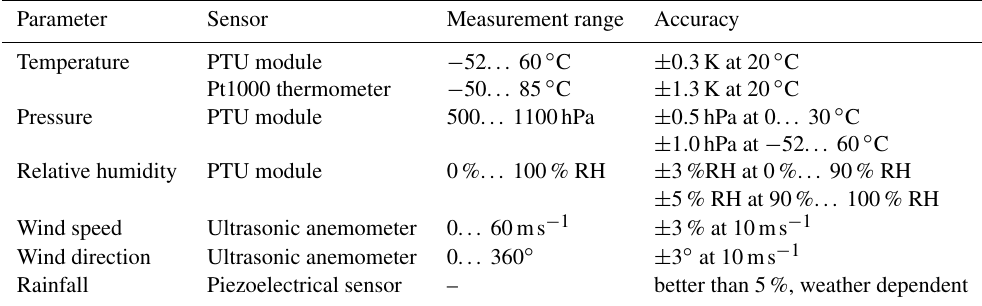
Table 2. Sensor specifications of WXT weather station (Vaisala, 2017).